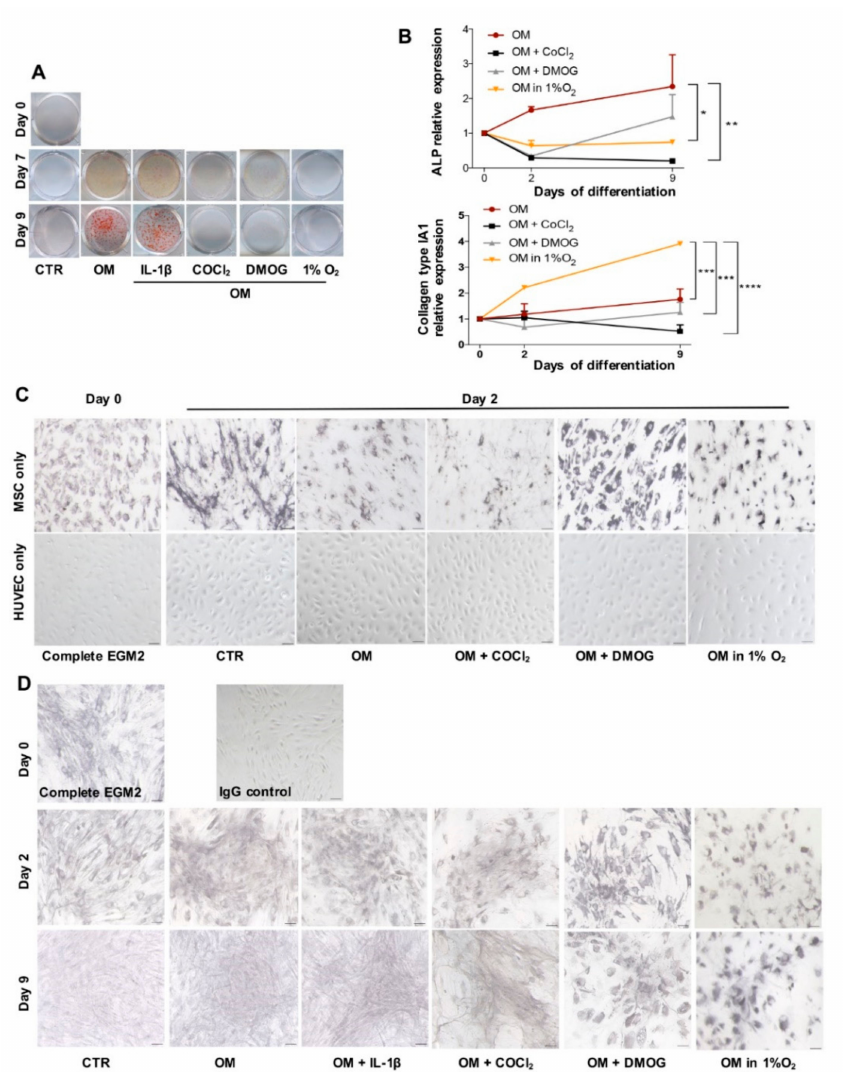
Figure 2. In vitro osteogenesis. ( A ) Alizarin Red S coloration shows the accumulation of calcium deposit (red) of cells cocultured in control medium (CTR), osteogenic medium (OM), OM added IL-1 β or COCl 2 or DMOG and OM in 1% O 2 at di ff erent time points (day 0, 7, 9). ( B ) qPCR analysis of gene expression of ALP and collagen type I over time (day 0, 2, 9) in conditions OM, OM added COCl 2 or DMOG and OM in 1% O 2 (n = 3, ∗ p = 0.0156, ∗∗ p < 0.0025, ∗∗∗ p = 0.0002, ∗∗∗∗ p < 0.0001). ( C ) IHC analysis illustrates Collagen type I expression (black) of BMSC and HUVEC in monoculture in medium Complete EGM2 at day 0 and in day 2 in media CTR, OM, OM supplemented with COCl 2 or DMOG and OM in 1% O 2 . Counterstaining was skipped, scale bar 50 µ m. ( D ) IHC analysis of cocultured cells over time in di ff erent conditions. IgG control means the section was not incubated with 1st antibody, scale bar 50 µ